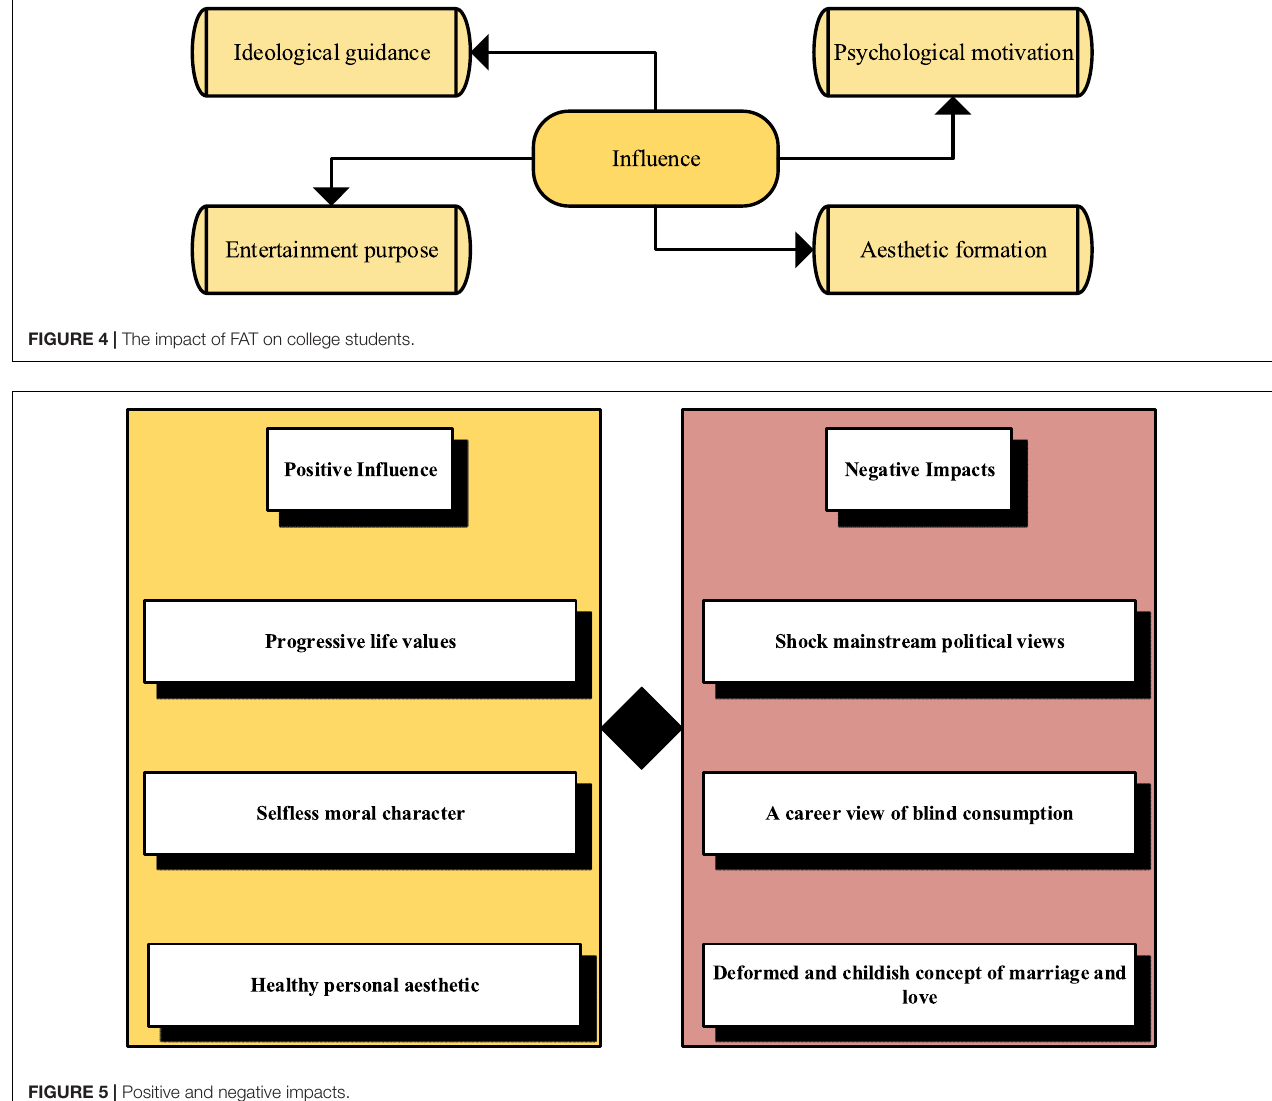
FIGURE 5 | Positive and negative